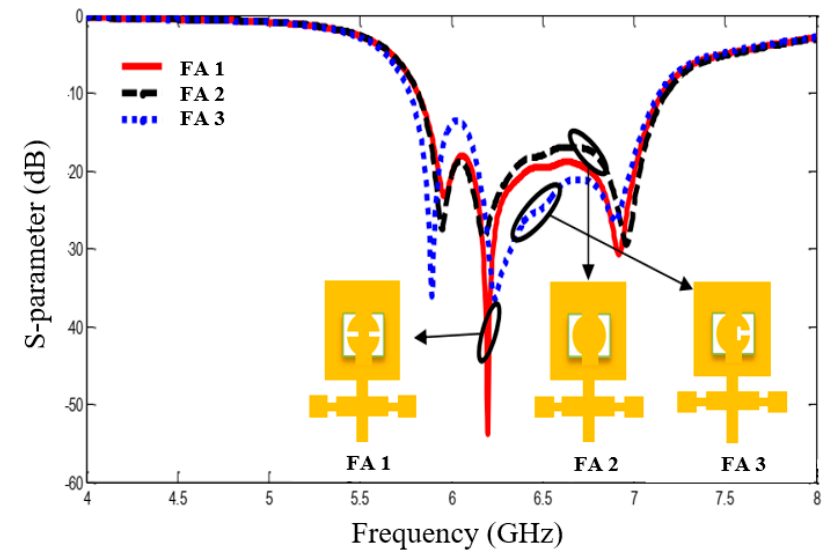
Figure 5. S11 ‐ parameter of the proposed filtering antenna (FA) for different shaped slots.